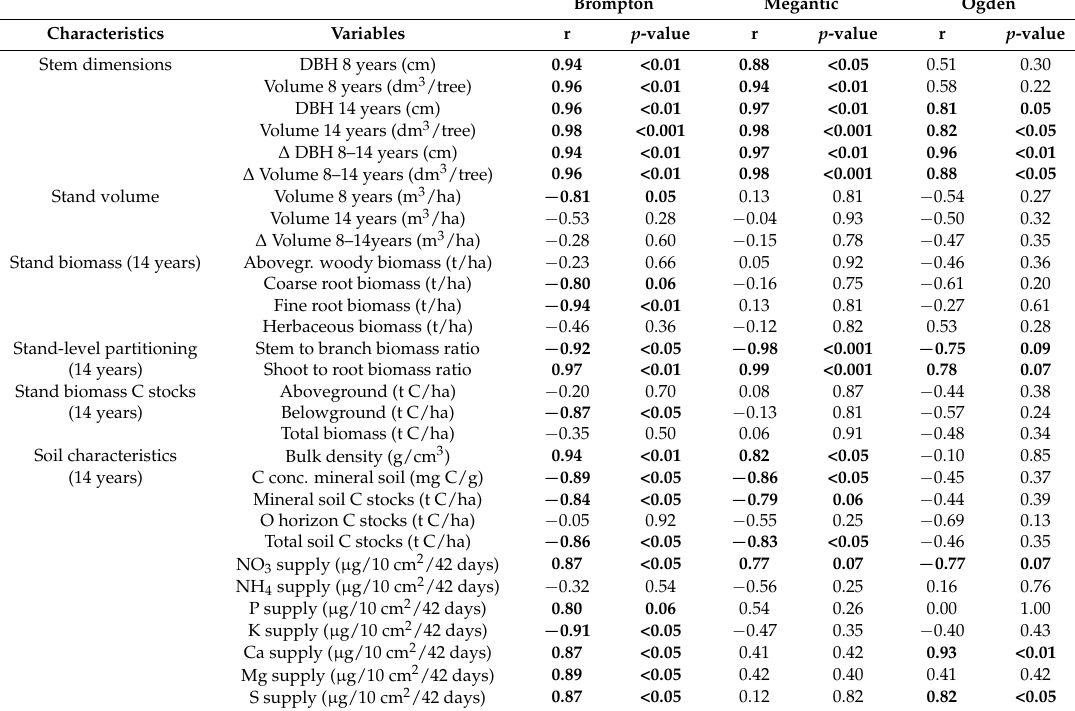
Table 7. Site-specific pairwise correlations (r) between area per tree at planting (m 2 /tree) and selected variables related to individual stem dimensions, stand-level characteristics and soil characteristics. Correlations with p < 0.10 are indicated in bold.